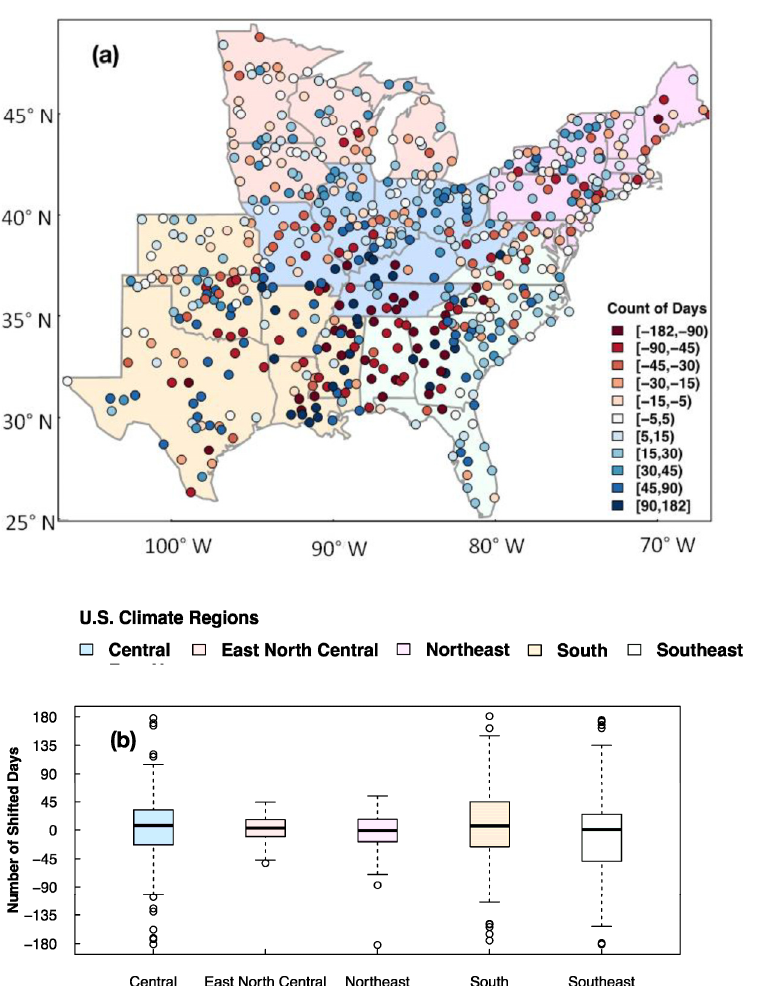
Figure 7. ( a ) Spatial patterns of temporal changes in the median day of year for two 35-year blocks (1950–1984 and 1985–2019) of annual maximum daily precipitation. ( b ) Regional distribution of shifting in median day of year of annual maximum daily precipitation, boxplots show the median, interquartile range, and full range.